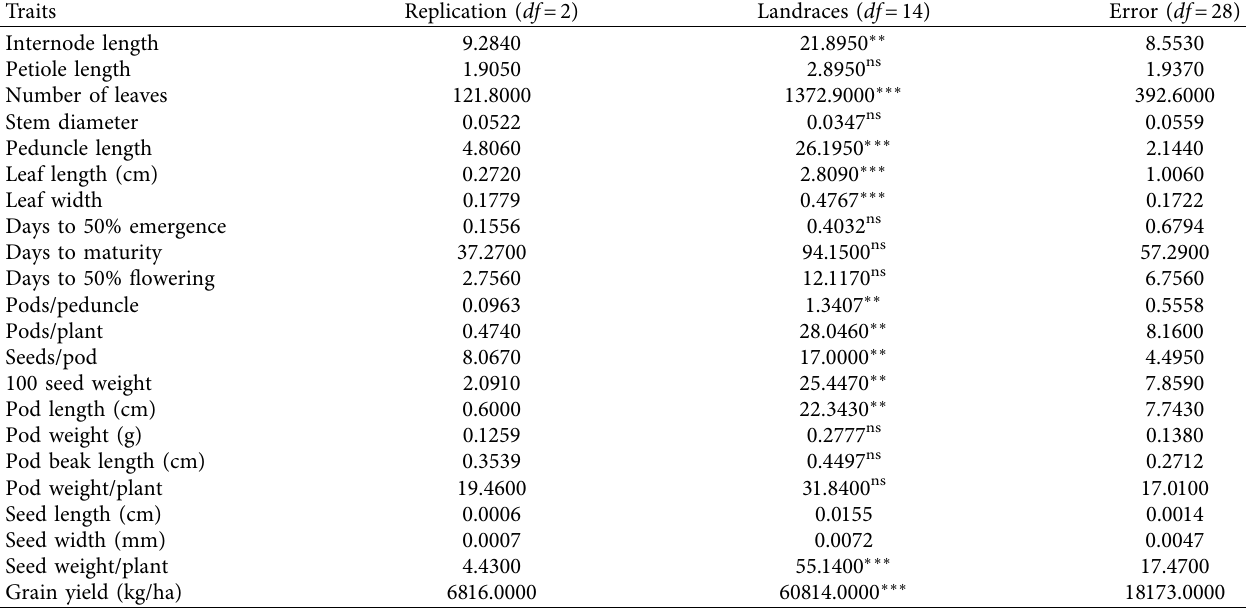
Table 2: Te mean square of the growth and yield and yield traits of AYB.